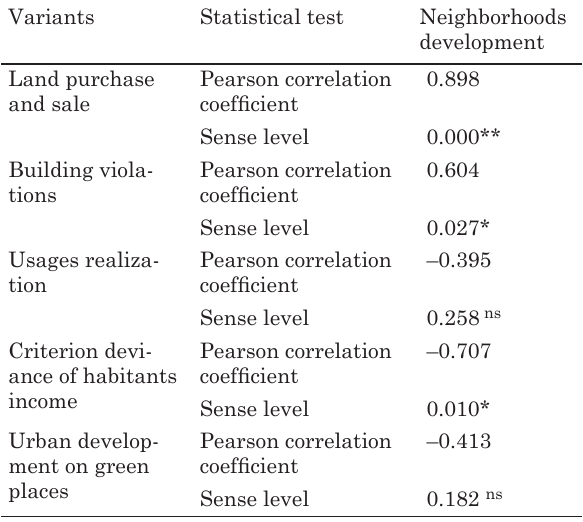
Table 8. Correlation relation between neighborhoods